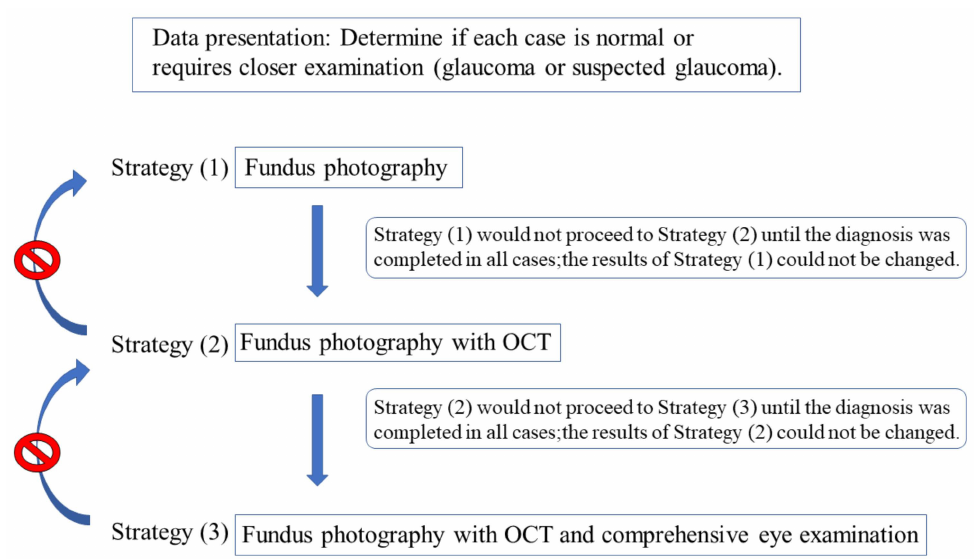
Figure 1. Diagnostic method based on three strategies. Diagnosis was performed in the order of the strategies (1), (2), and (3). Once the judges proceeded to the next strategy, their answers could not be